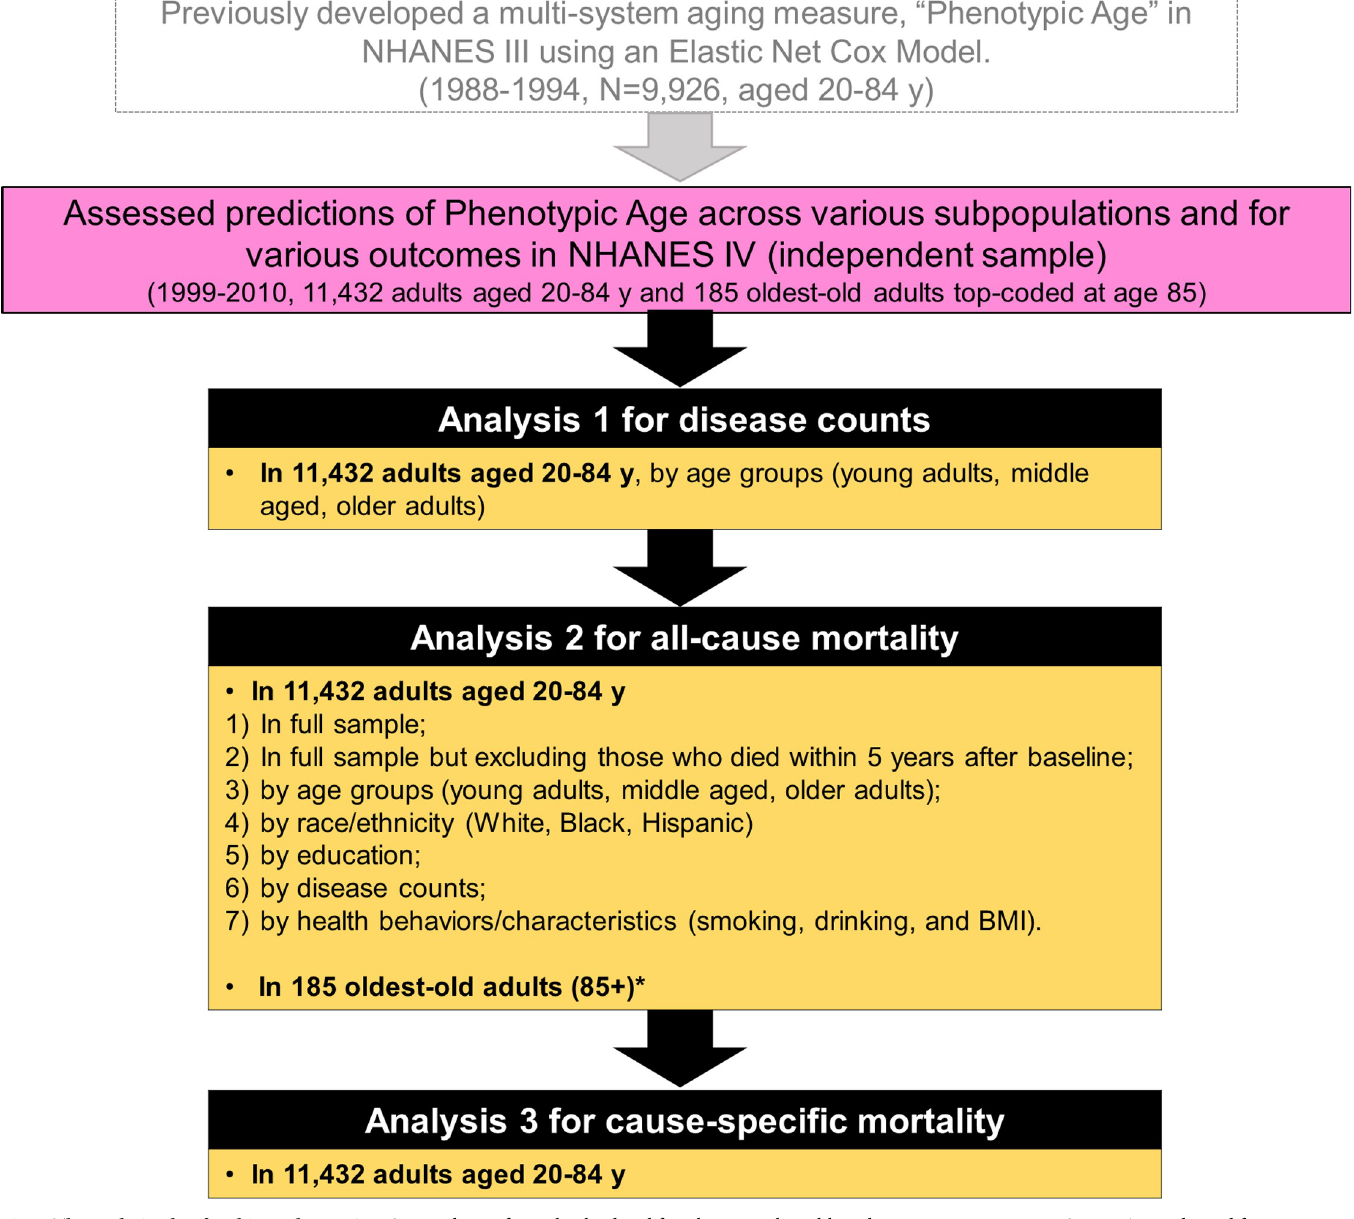
Fig 1. The analytic plan for this study. NHANES III and IV refer to the third and fourth National Health and Nutrition Examination Survey. � We adjusted for chronological age and sex in all models except those in the oldest-old adults. As mentioned in the Methods, we ran 2 parametric proportional hazard models (Gompertz distribution) in this age group, one unadjusted and another with adjustment for disease count, rather than chronological age (unknown).BMI, body mass index. persons in the highest 20% versus the lowest 20%. We also compared predicted median life expectancy at age 65 years by sex and the 5 quintiles for PhenoAgeAccel. Next, receiver operat- ing characteristic (ROC) curves were used to compare the 10-year mortality risk prediction of Phenotypic Age to predictions based on individuals’ clinical chemistry biomarkers and routine risk assessment tools (e.g., based on systolic blood pressure, the biomarkers, and BMI).